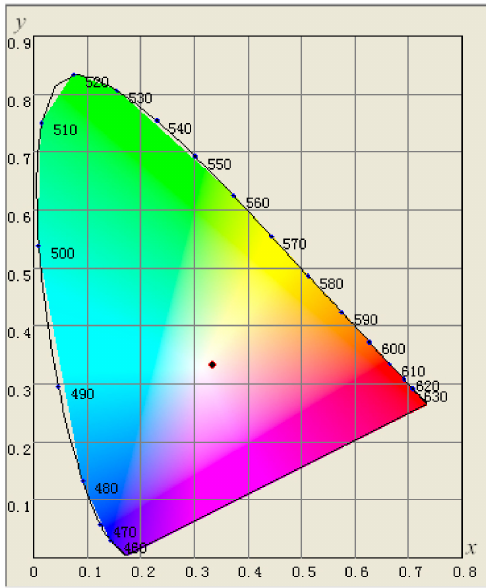
Figure 3. 1931CIE-XYZ system color map spectrum three stimulus value. The area of the horseshoe is the area for calculating the color distribution of color. The value of the boundary of the horseshoe diagram is the color represented by the spectrum of different